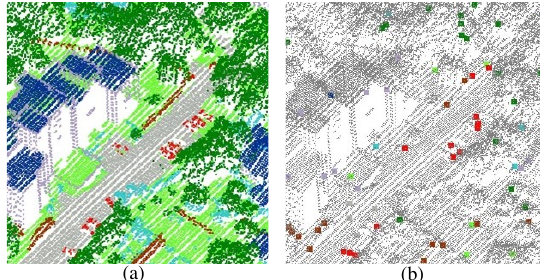
Figure 1. Comparison of (a) fully-labeled points and (b) weak- label. (b) Situation in which only 100 points per class ( 2